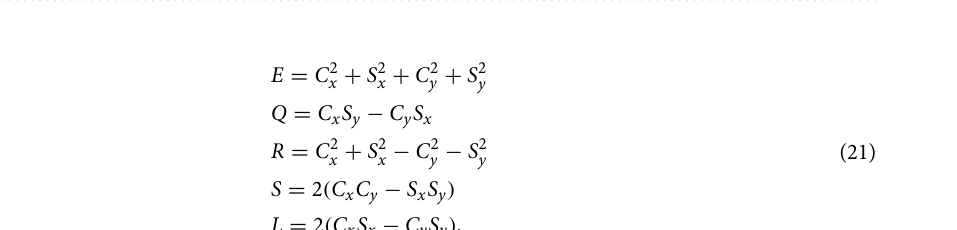
Figure 4. Interface architecture for the HRG